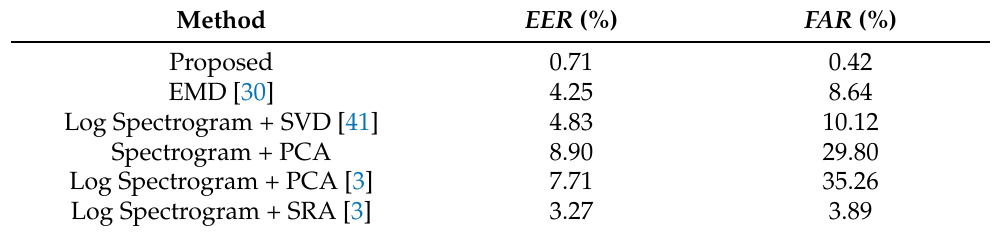
Table 7. Comparison of the proposed method with state-of-the-arts in terms of EER and FAR FRR = 1%